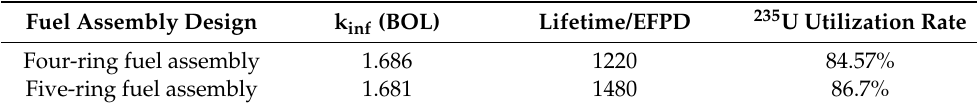
Table 5. Calculation results of different fuel assembly